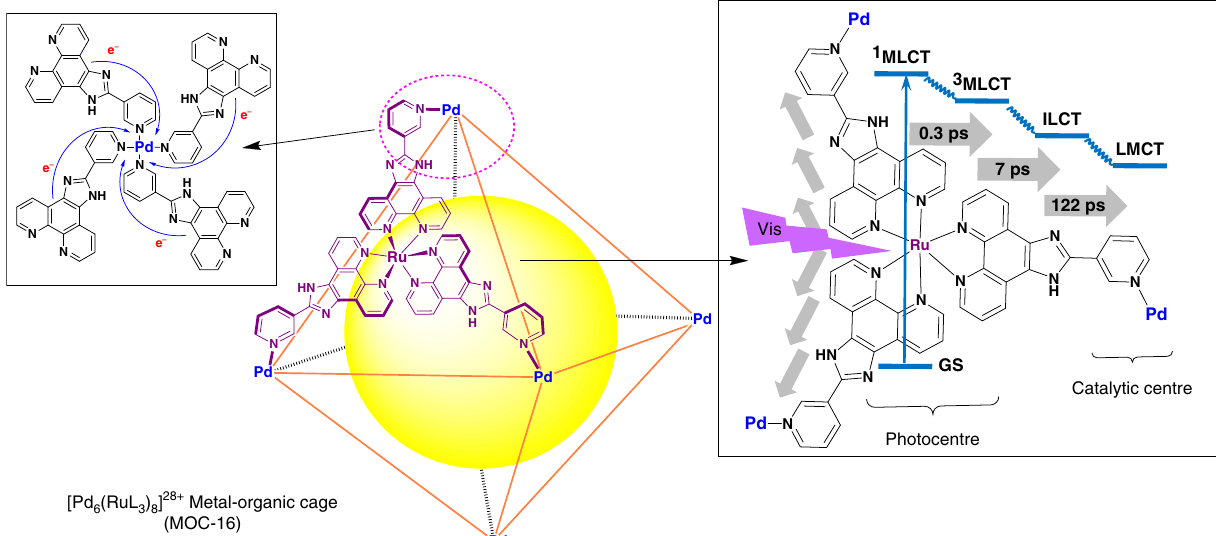
Figure 1 | PMD structural model. Octahedral cage structure of [Pd 6 (RuL 3 ) 8 ] 28 þ and the multi-channel electron transfer pathways between chromophoric Ru and catalytic Pd metal centres. GS, ground state; ILCT, intraligand charge transfer; LMCT, ligand-to-metal charge transfer; MLCT, metal-ligand charge